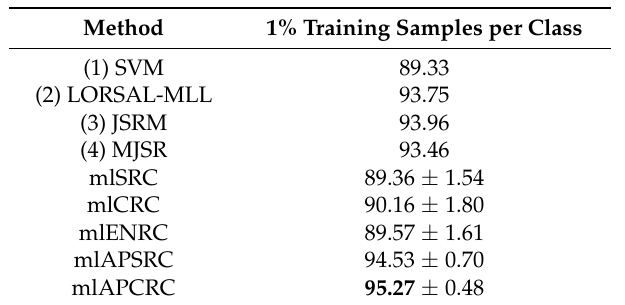
Table 11. Comparison of methods, denoted as mlSRC, mlCRC, mlENRC, mlAPSRC and mlAPCRC, with results reported in (1) to (4) [29] for the Salinas image. The best OA results of each table are marked in bold. SVM, support vector machine; LORSAL-MLL, logistic regression via variable splitting and augmented Lagrangian-multilevel logistic; JSRM, joint sparse representation model; MJSR, multiscale joint sparse